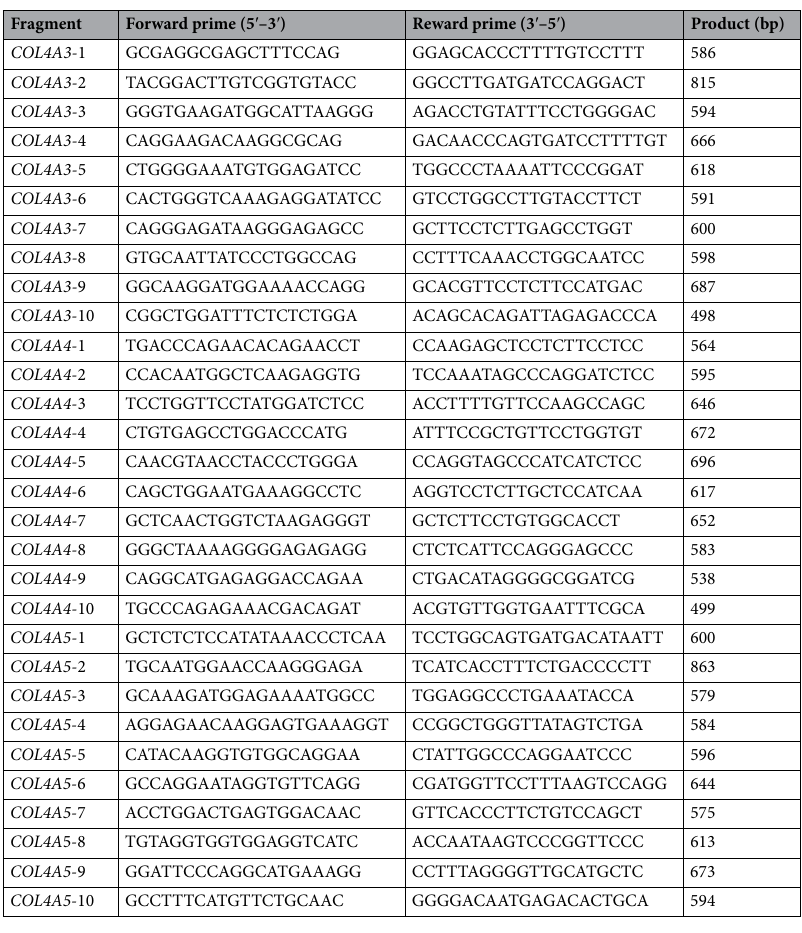
Table 3. Primers for COL4A3 - 5 cDNA analysis. The reference sequence of COL4A3-5 transcripts was NM_000091.5, NM_000092.5, and NM_000495.5,